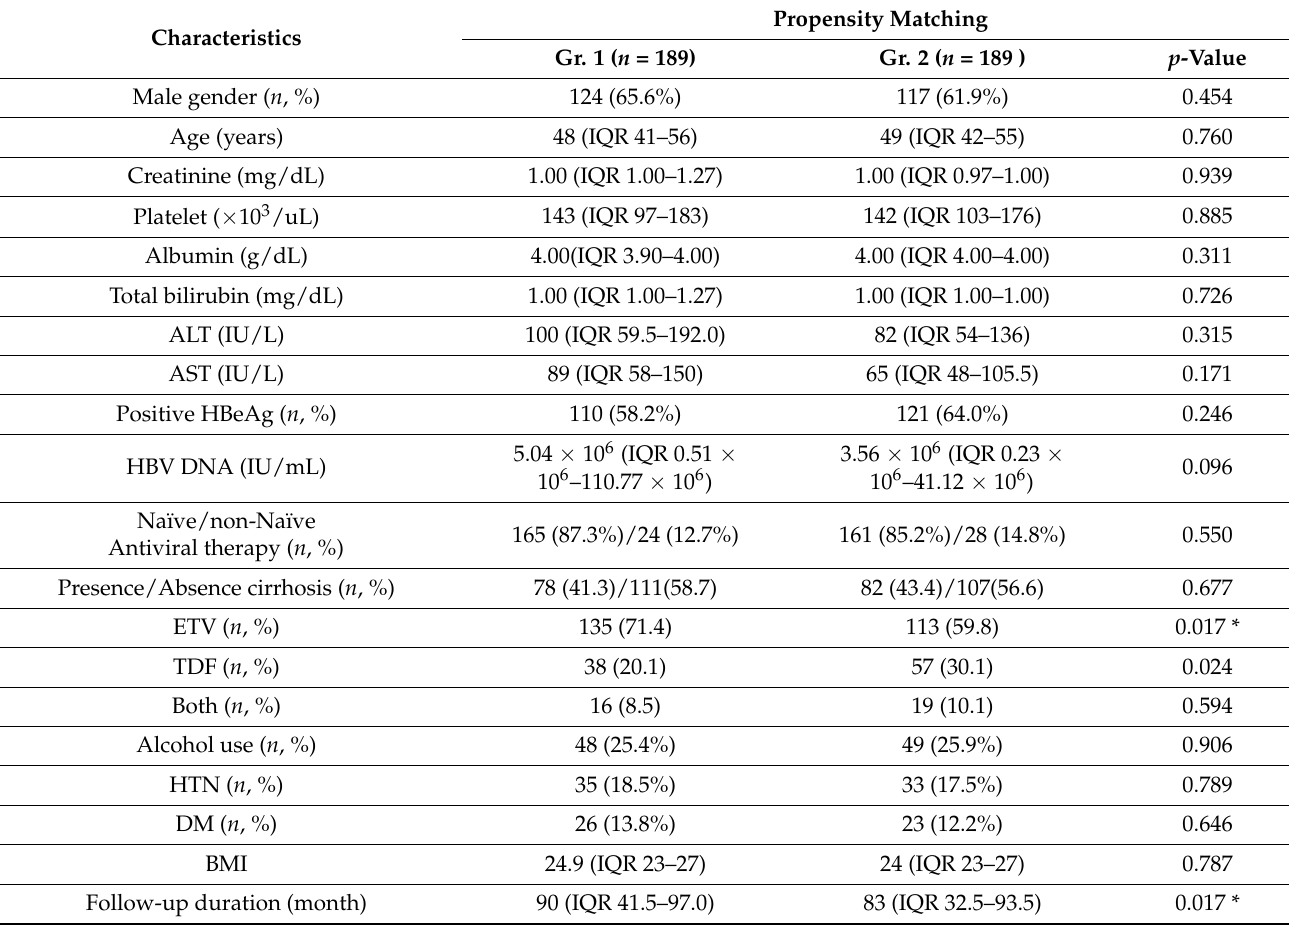
Table 2. Baseline characteristics of patients with CHB-with ALT normalization (Gr.1) or –without ALT normalization (Gr.2) within 1 year of potent antiviral treatment after propensity